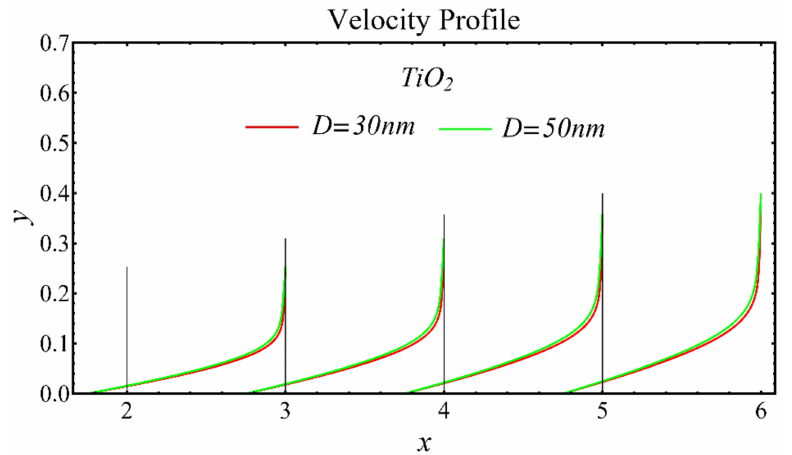
Figure 12. Velocity profile of TiO 2 -EG nanofluid under influence of nanoparticle